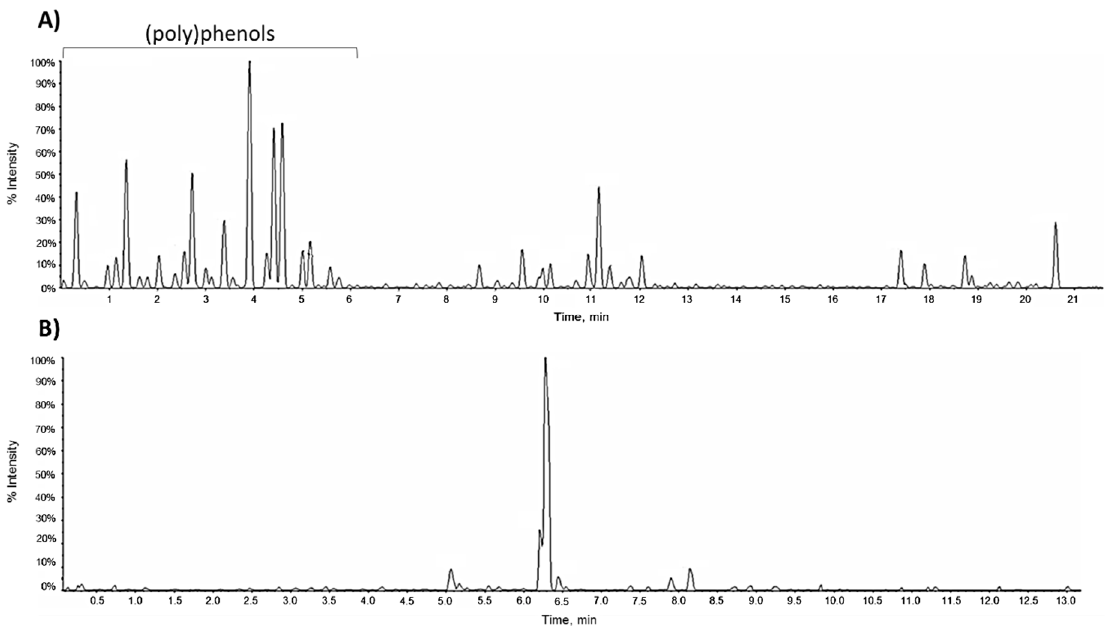
Figure 1. TIC (Total Ion Chromatogram) of ( A ) EtOH extract and ( B ) GrM fraction from Greco di Tufo vine leaves.